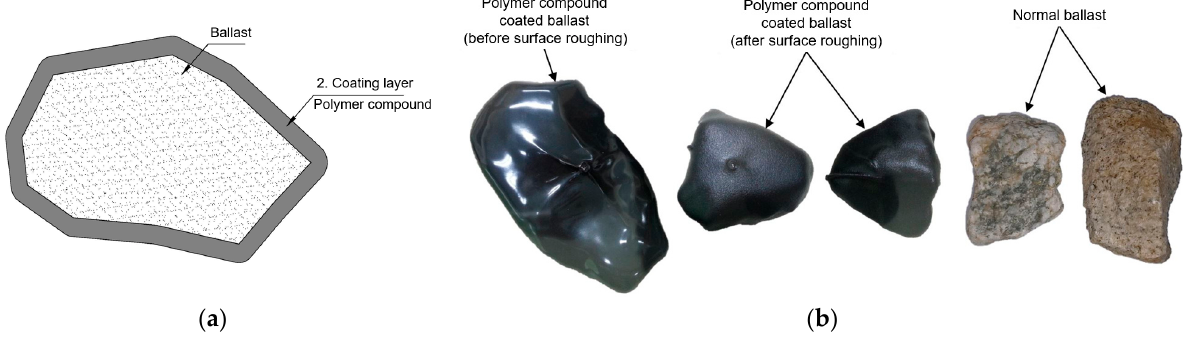
Figure 3. Comparison of normal ballast and coated ballast: ( a ) Coated ballast cross-section. ( b ) Comparison of coated ballast and normal ballast before and after surface roughing.